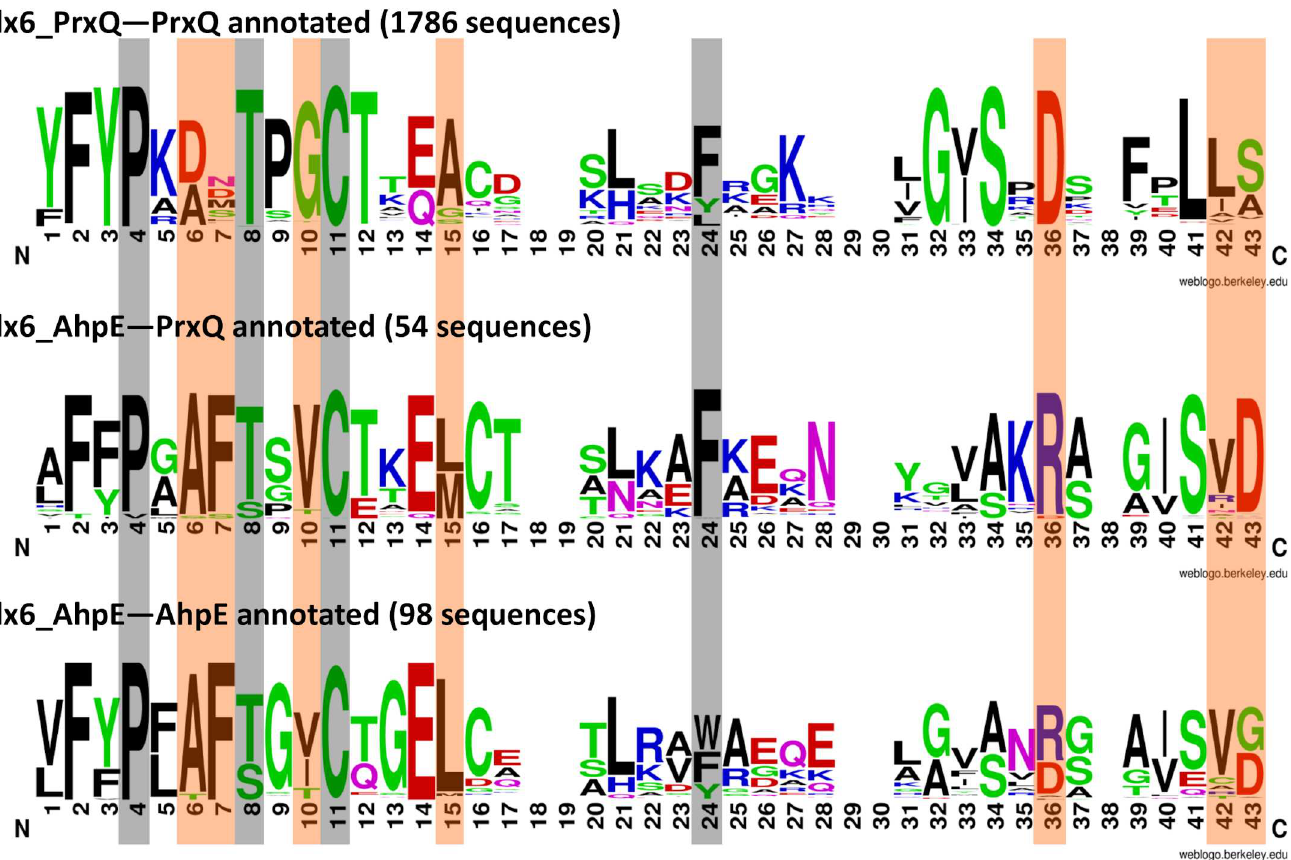
Fig 10. Comparison of AhpE and PrxQ signaturessuggests why 54 previouslyannotated PrxQ proteins are identified in the Rlx6_AhpE MISST group. Signatureconservation graphsweremadefor all proteinspreviouslyannotated as PrxQ in the Rlx6_PrxQgroupandallproteinspreviously annotated as PrxQ or AhpEin the Rlx6_AhpE MISST group.Gray highlightsrepresentthe key residuesusedto initiateTuLIP. Orangehighlightsrepresentpositionsin whichRlx6_AhpE proteinsannotated as PrxQ sharemore similarity with theAhpE subgroup thanthe PrxQ subgroup.Signatureconservation graphswere madeusingWeblogo version2.8.2 [61]with